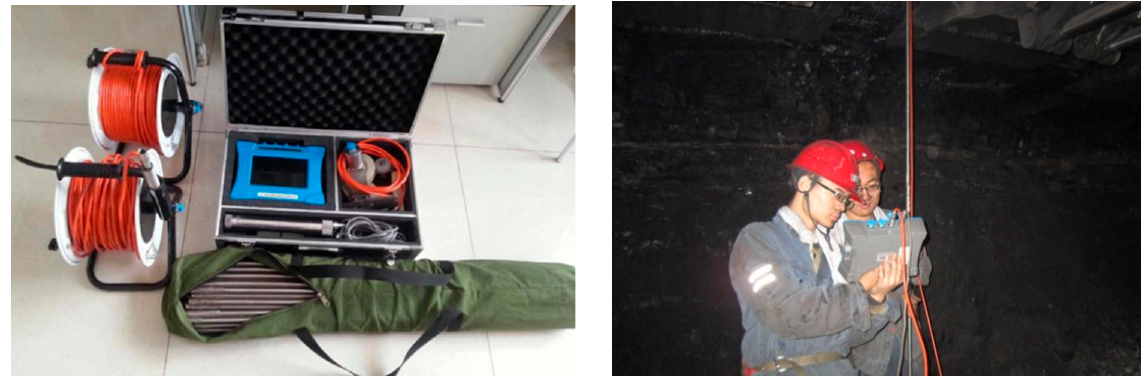
Figure 15. ZKXG30 borescope and field observation.